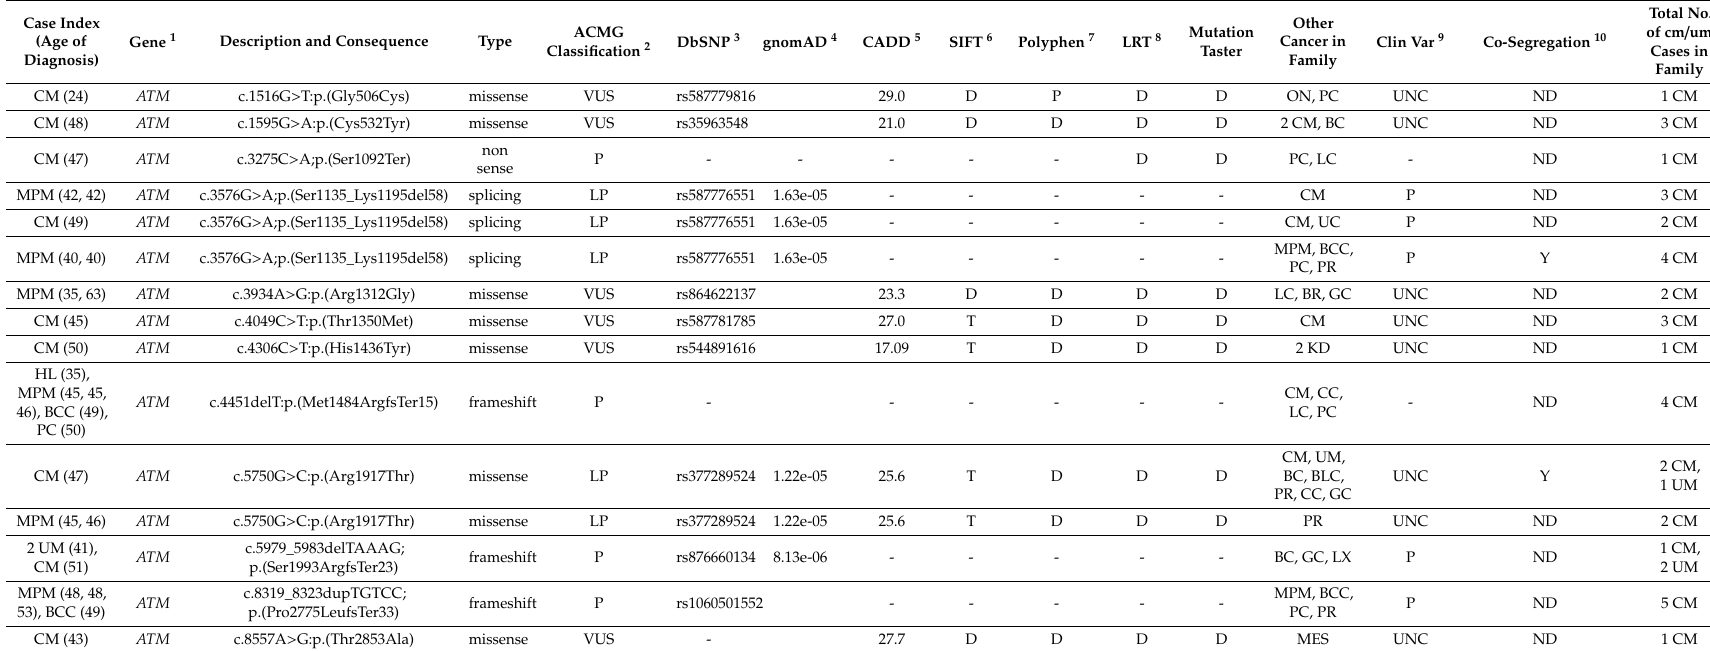
Table 2. Rare variants of interest in ATM candidate